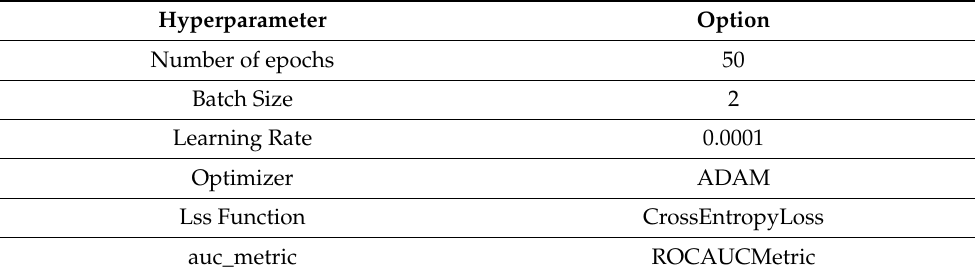
Table 7. Network